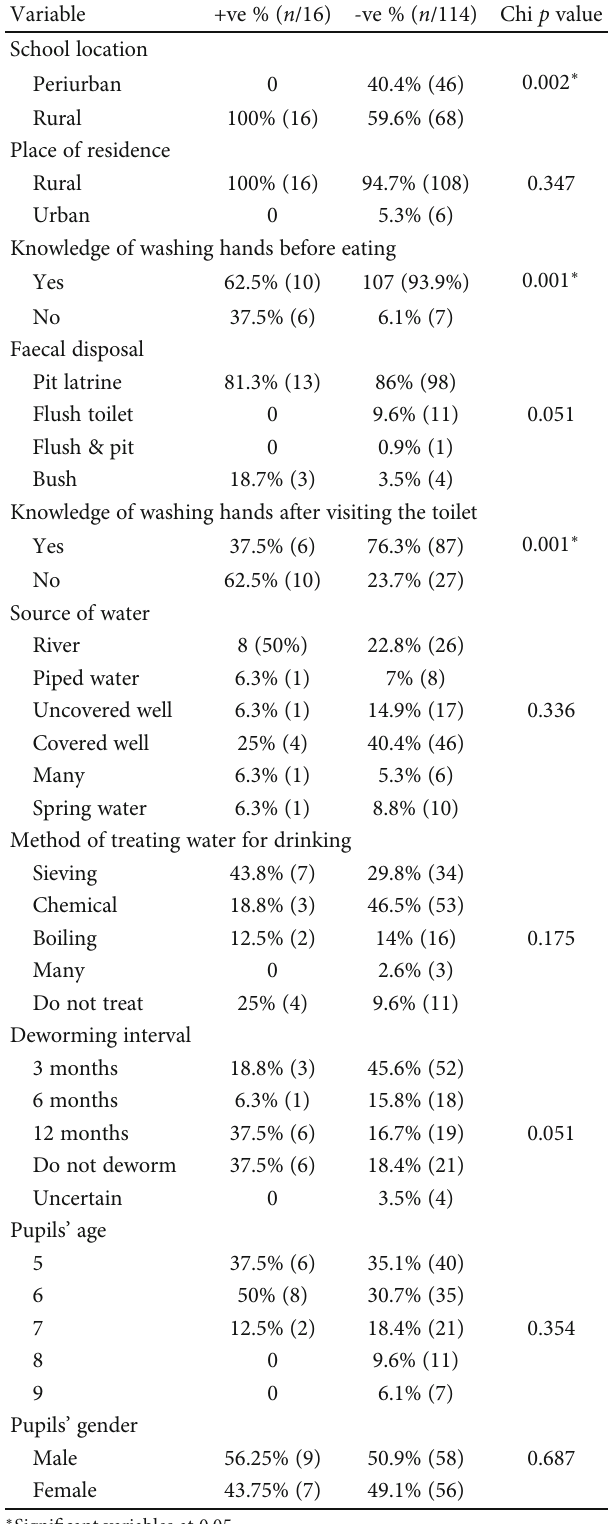
Table 3: Association between prevalence and risk factors.